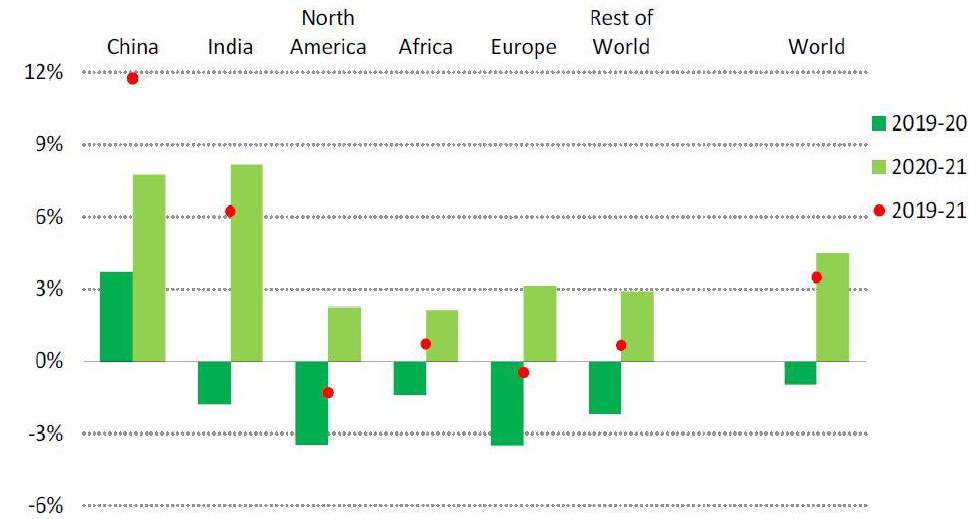
Figure 3. Changes in electricity demand by region between 2020 and 2021 [47]. Source: IEA (2021) Global Energy Review 2021. All rights reserved.